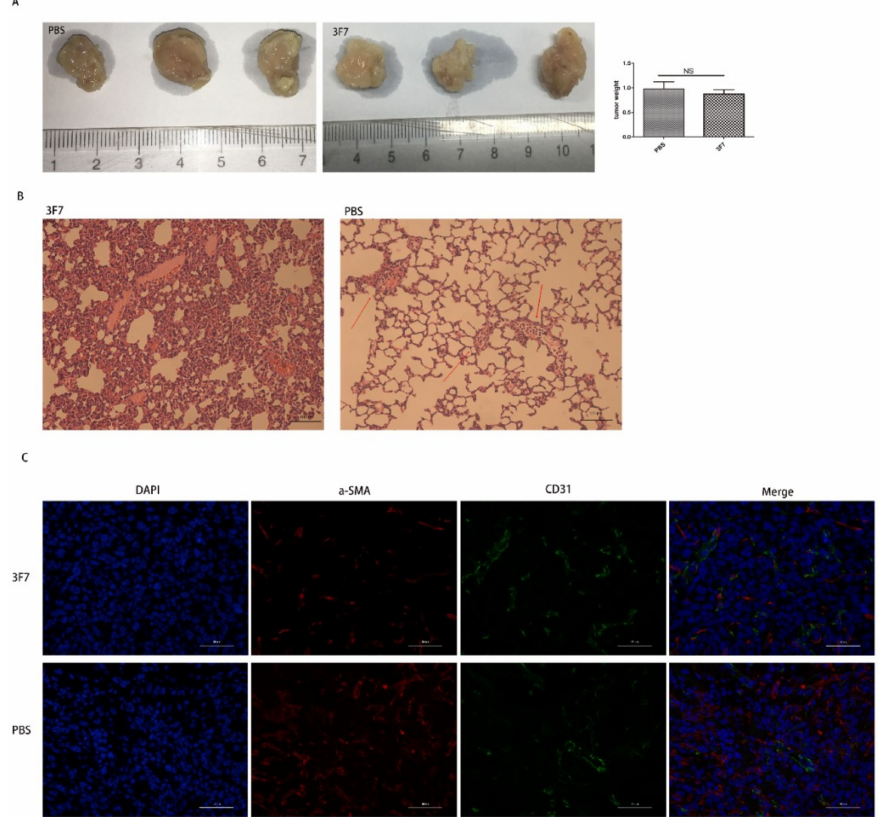
Figure 7. The 3F7 antibody repressed the 4T1 lung metastasis in vivo: ( A ) the tumor weight after treatment with 3F7 or PBS; ( B ) the mouse 4T1 breast cancer lung metastasis (200 × ); and ( C ) the indirect immunofluorescent double staining with the α -SMA antibody and CD31 antibody (400 × ). The data are shown as means ± SD ( n ≥ 3) and analyzed by t -test; NS, not